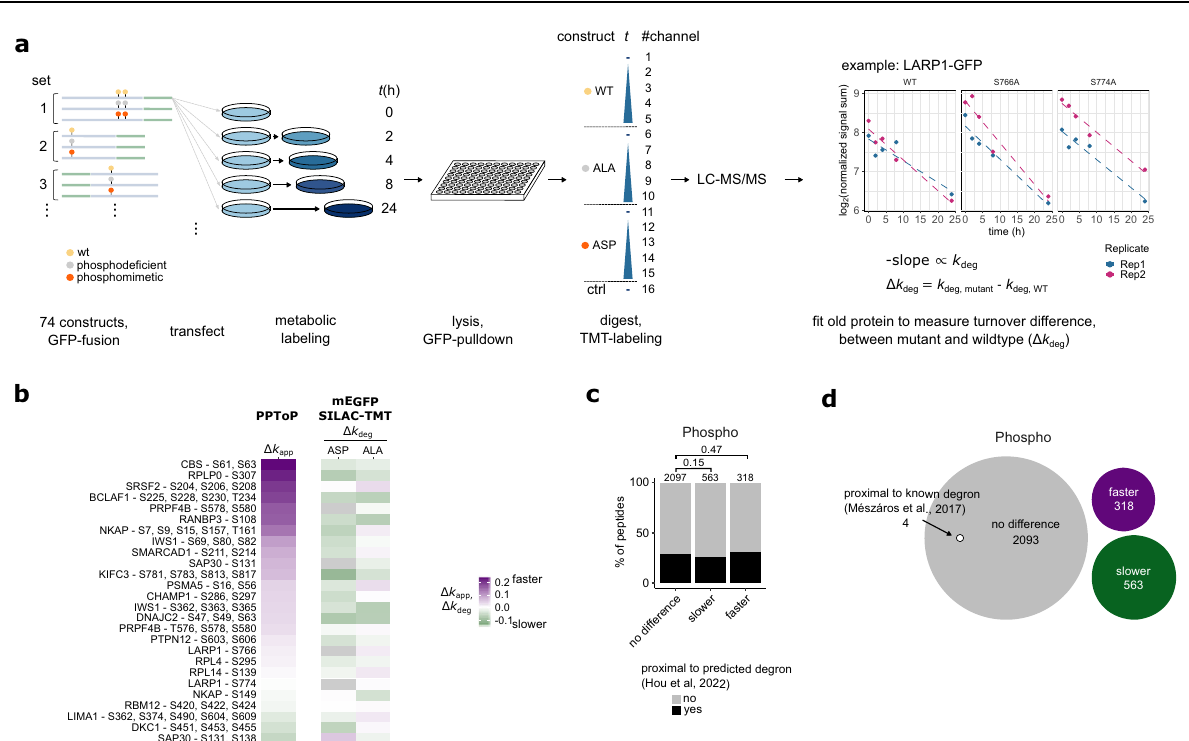
signi fi cant correlation (see also SupplementaryFig.6b), indicating thatdifferences in clearance measured from PPToP are not predictive of differences in protein degradation caused by the PTM. c Phospho PPToP hits are not enriched for being proximaltopredicteddegrons 25 .Proximitywasde fi nedbyconsideringwhetherany part of a predicted degron overlaps with a 31 amino acid stretch centered on the measured peptide. Fisher ’ s exact test, two-sided. d No known degrons 26 lie prox- imal to the measured Phospho PPToP hits. Source data are provided as a Source data fi